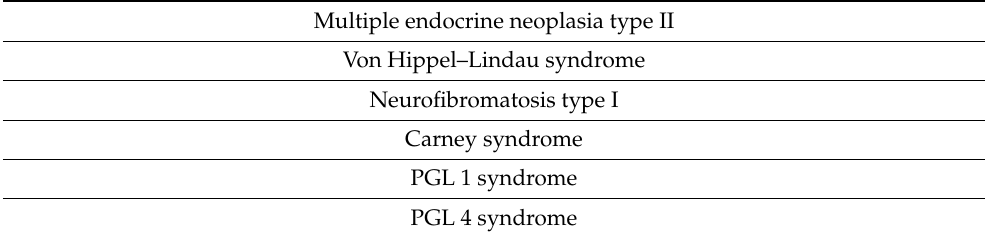
Table 5. Familial syndromes with hereditary forms of